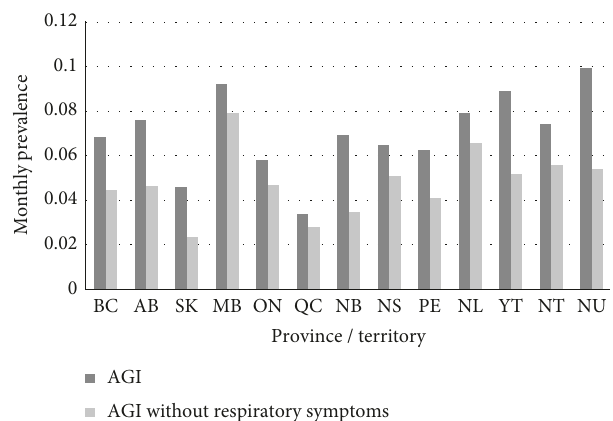
Figure 1: Monthly prevalence of self-reported AGI by prov- ince/territory,